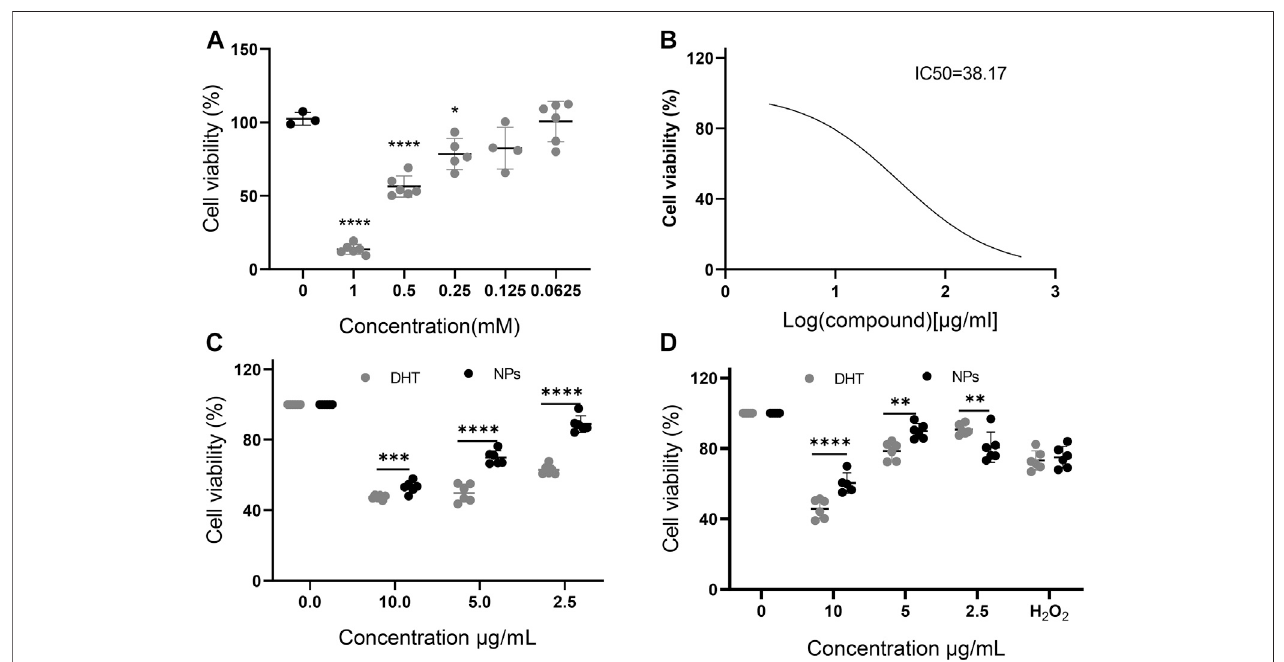
FIGURE 2 | The in fl uence of H 2 O 2 , DHT, and DHT – BSA NPs on PC12 cell viability. (A) Different concentrations of H 2 O 2 act on the cell viability after 12 h. (B) The half-inhibitory concentration ofDHT – BSANPs on PC12 cells. (C) The effect of DHTand DHT – BSANPs on cell viability. (D) The effect ofDHT and DHT – BSANPs on cell viability after adding H 2 O 2 . The data represent the mean ± SD ( n (cid:1) 6 in each group). * p < 0.05, ** p < 0.01, *** p < 0.001, and **** p <